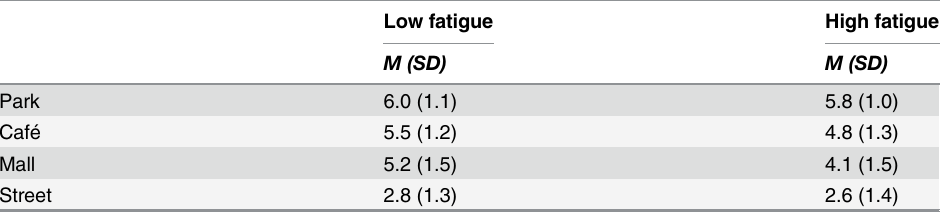
Table 8. Preference scores (means and standard deviations) for the four settings under low or high attentional